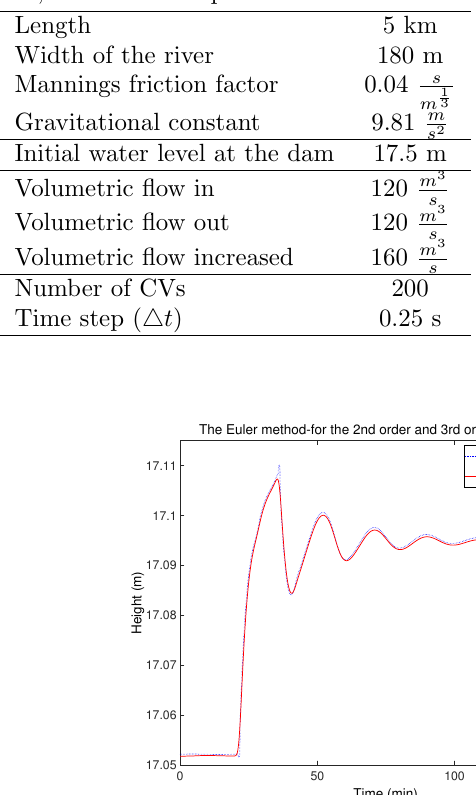
Table 1: Parameter, variables and quantities